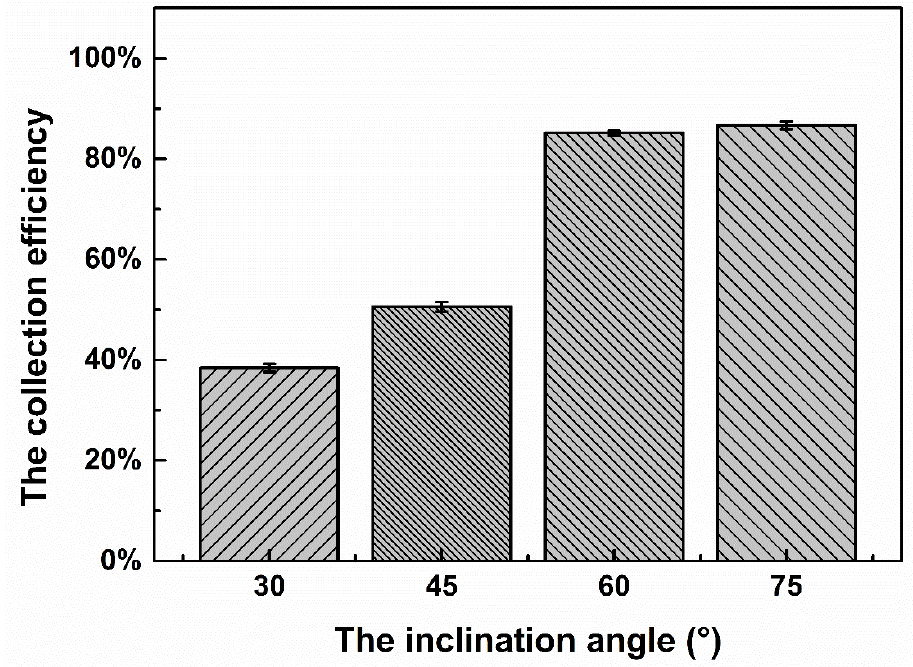
Figure 6. E ff ect of the inclination angle on the collection e ffi ciency of 37- µ m Figure 6. Effect of the inclination angle on the collection efficiency of 37- μm particles.